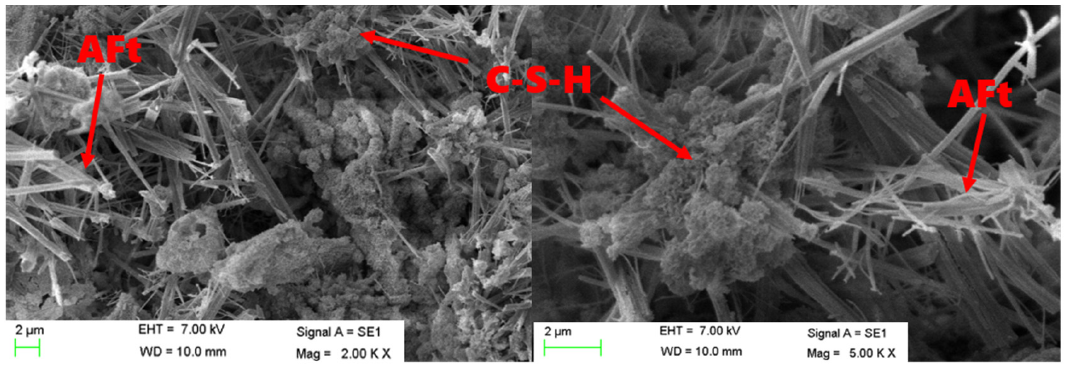
Figure 6. SEM images of hydration products of No.2 at 28 d age.